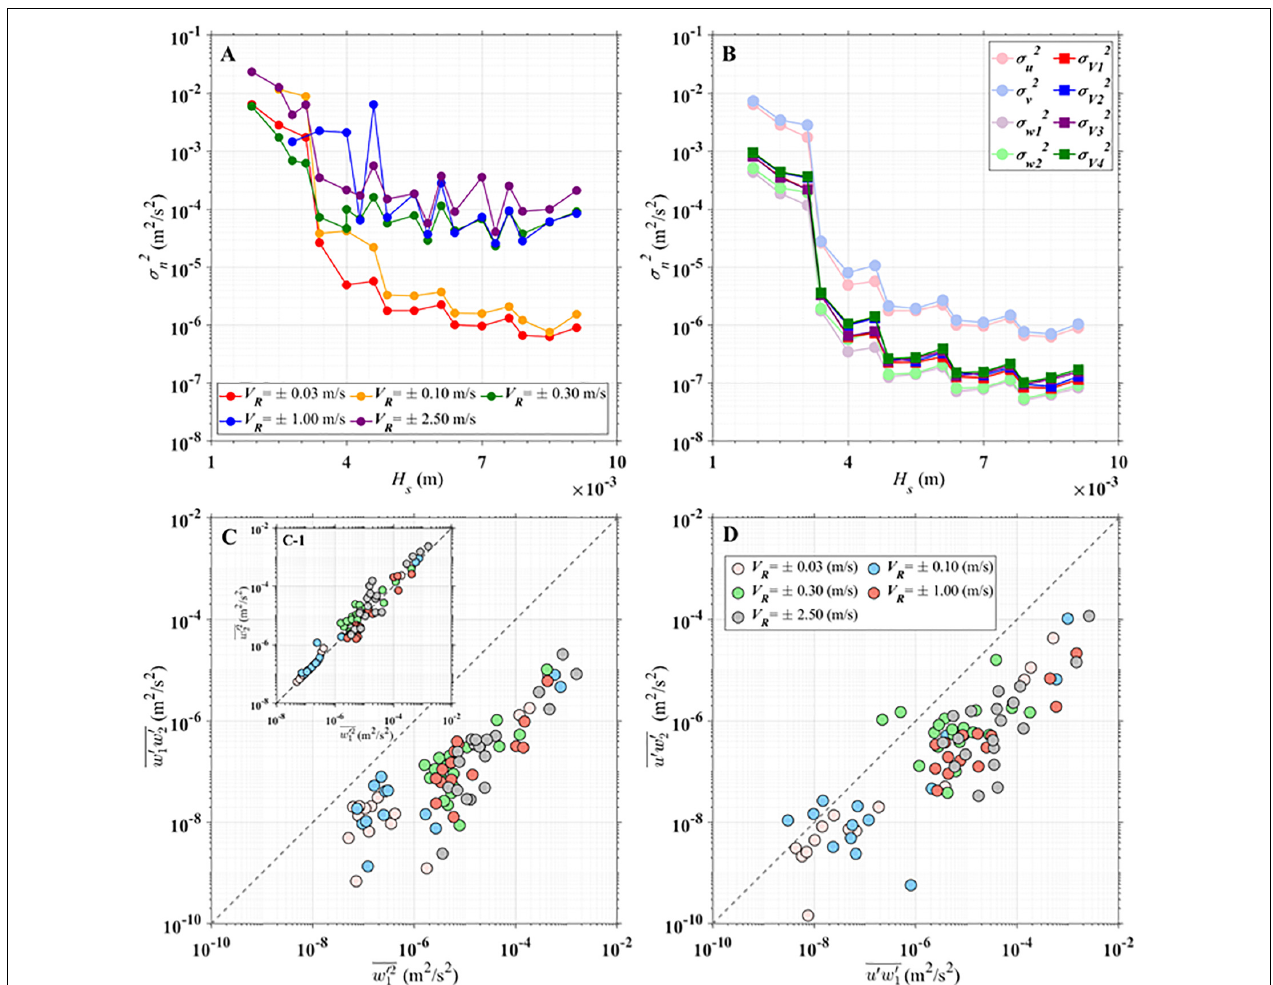
FIGURE 3 | (A) Relation between the noise variance of stream-wise velocity component and the height of sampling volume in the different velocity ranges for setup. (B) The relation between the noise and the height of sampling volume for V R = ± 0.03 m/s. Relationship between (C) w (cid:48) 12 and w (cid:48) 1 w (cid:48) 2 and between (D) u (cid:48) w (cid:48) 1 and u (cid:48) w (cid:48) 2 in different velocity ranges: the dotted lines mean that y = x